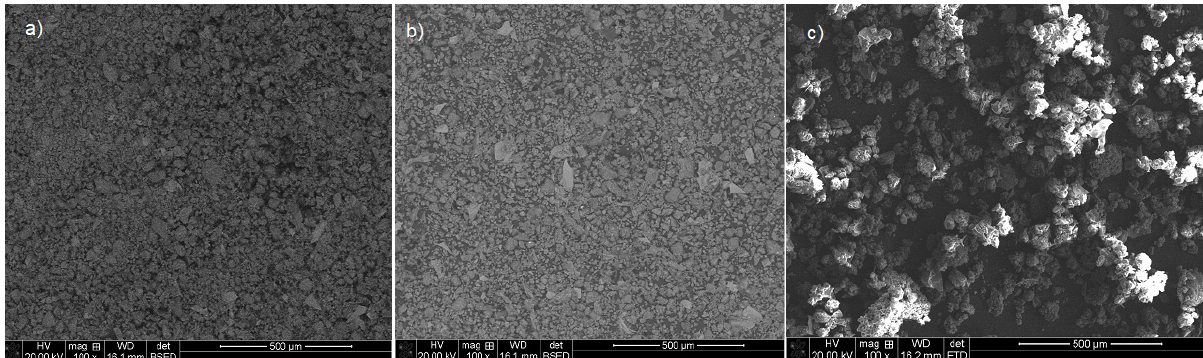
Figure 7. SEM images of ( a ) treated bleaching clay, ( b ) AHIBC, and ( c ) Y ions loaded on AHIBC.